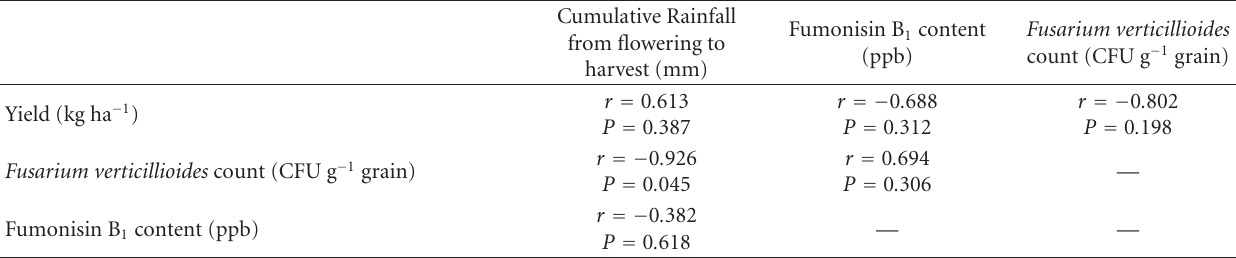
Table 4: Correlations between maize yield, fumonisin B 1 content and F. verticillioides count of harvested grains and rainfall